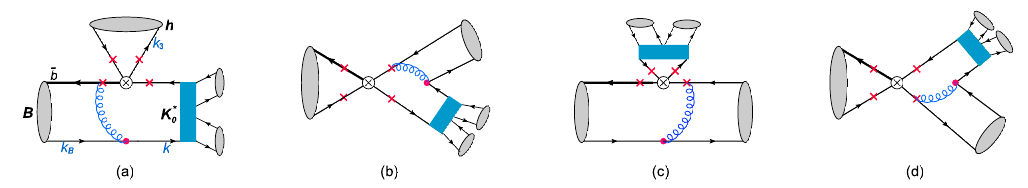
Figure 1 . Typical Feynman diagrams for the decay processes B ! K (cid:3) h ! K(cid:25)h , h =( (cid:25); K ). The 0 symbol (cid:10) is the weak vertex, (cid:2) denotes possible attachments of hard gluons and the rectangle represents the scalar resonances K (cid:3) 0